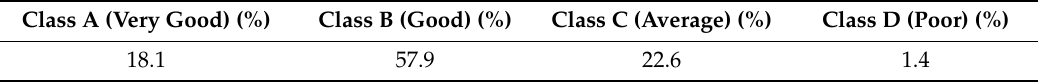
Table 3. Percentage of real profiles belonging to a specific ISO 8608 class.